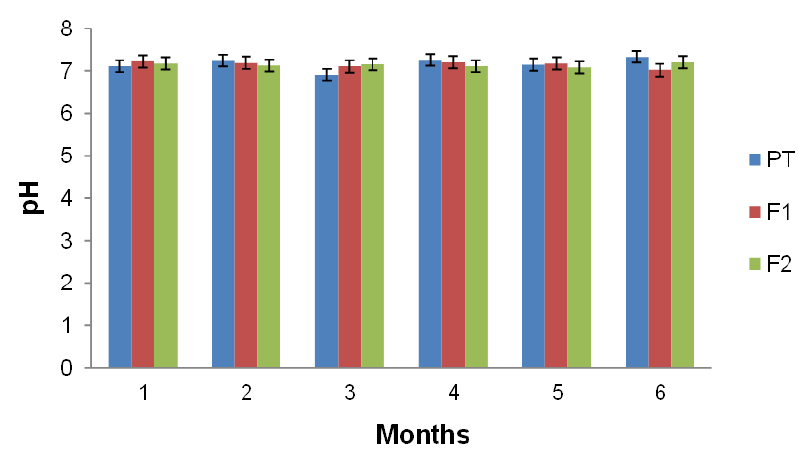
Figure 1. Industrial-scale pH measurements in each month of the experiment.